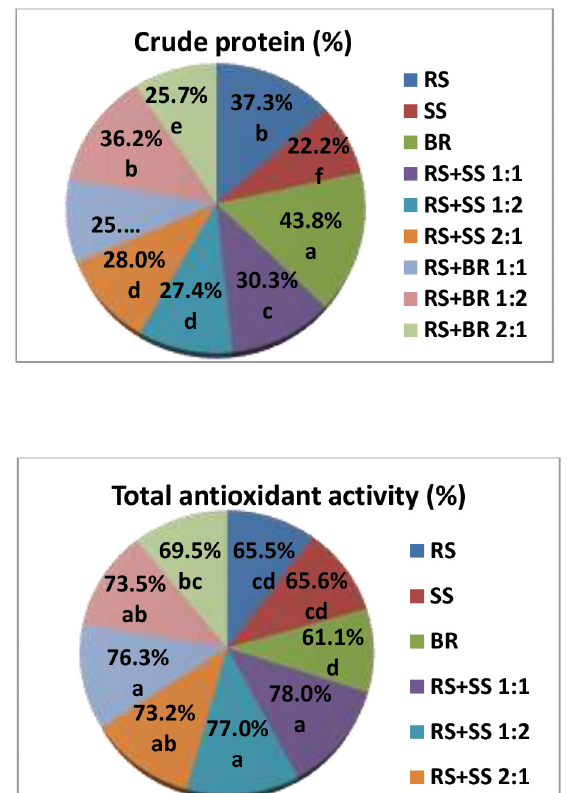
Fig. 4 Total antioxidants activity of oyster mushroom (